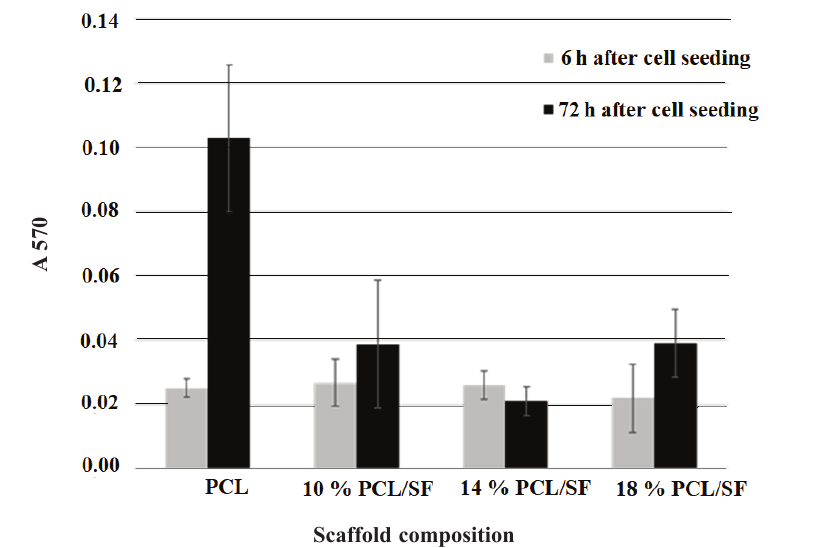
Fig. 10 – Formazan absorbance (A570) as indicator of HaCaT cell confluence on the electrospun PCL/SF scaffolds. During MTT assay, viable cells growing on the scaffolds produce formazan, which is a purple metabolic derivate of tetrazolium salt. Scaffold sam- ples without cells were used as the